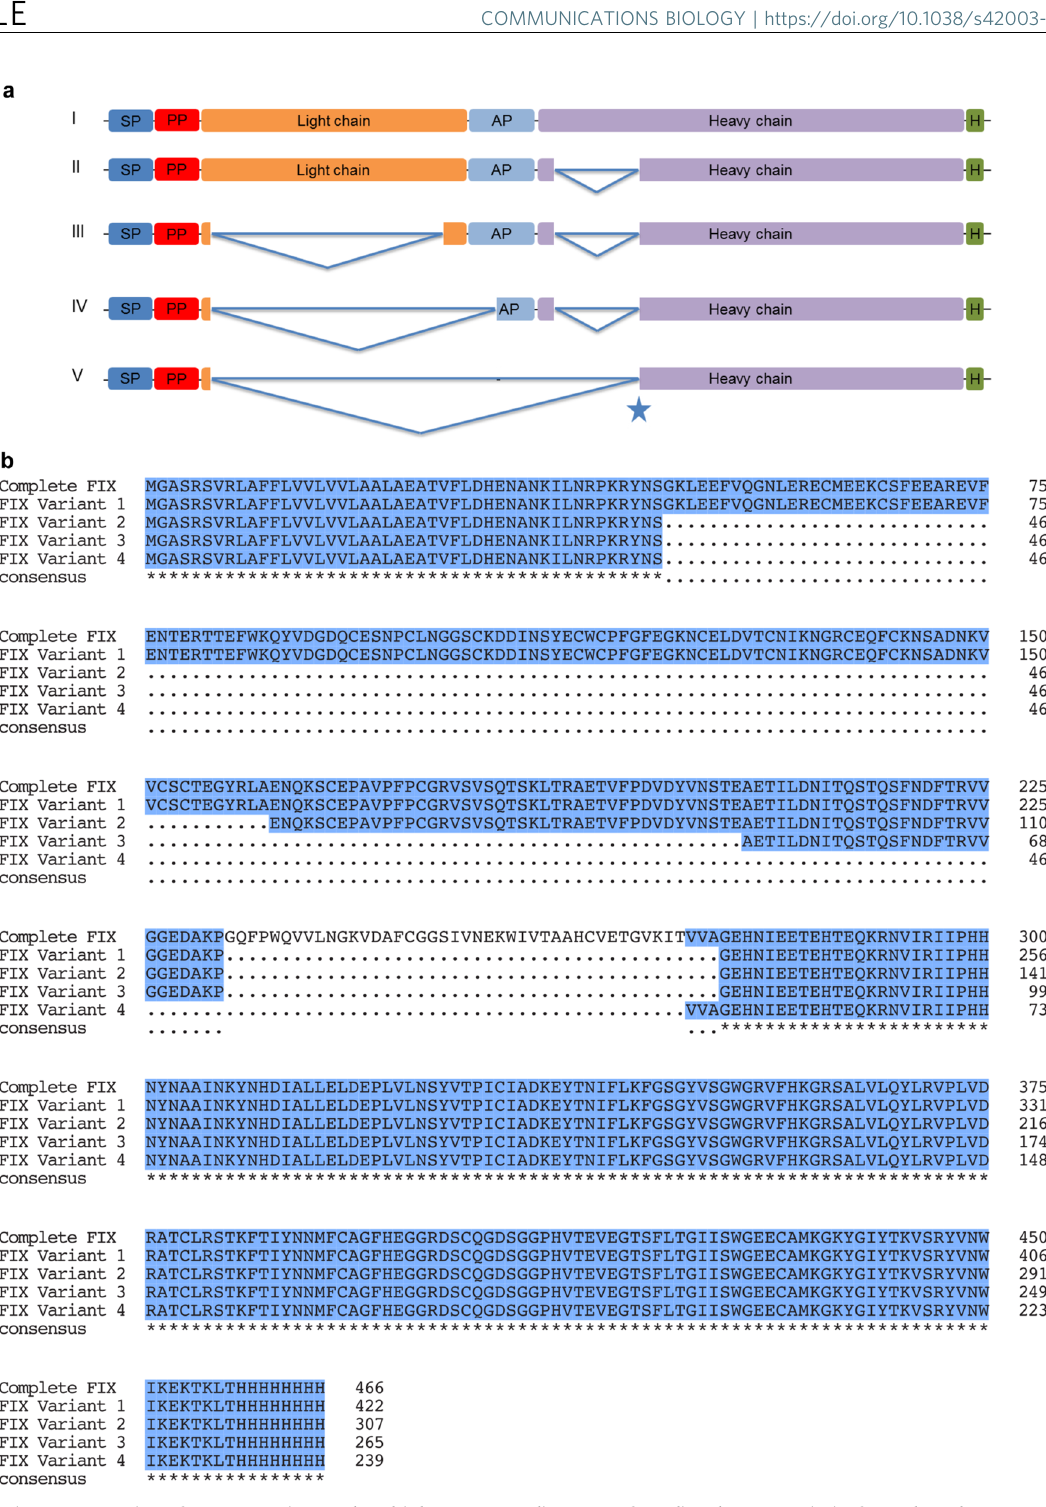
Fig. 2 Schematic representation of FIX transcripts and multiple sequence alignment of predicted FIX protein isoforms based on experimentally veri fi ed transcripts detected in Physcomitrella. a Full-length FIX transcript ( a .I), FIX variant with the deletion of a 44 aa long domain in the CDS for the heavy chain ( a .II), FIX variant with deletions in the CDS for both light and heavy chain ( a .III), FIX variant with deletions in the CDS for light chain, activation peptide and heavy chain ( a .IV), FIX variant missing the CDS completely for the activation peptide, nearly full-length of light chain and 41 aa long domain in the heavy chain ( a .V). The star indicates the usage of a acceptor site 9 bp earlier than previously identi fi ed acceptor site in the heavy chain. SP PpAP1 signal peptide, PP propeptide, AP activation peptide, H 8x His tag. b Alignment was performed and formatted for publication with MUSCLE via the “ MSA ” package for